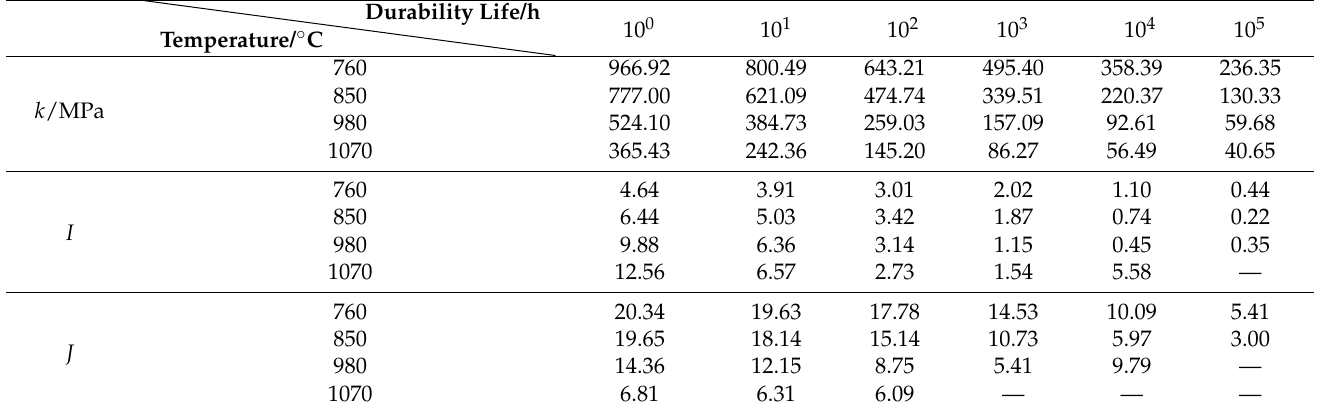
Table 8. DD6 material parameters at different